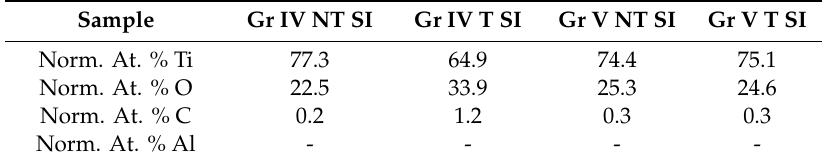
Table 7. Atomic percentages of the elements of the treated with TiO 2 film and non-treated SLA grade IV and V samples and treated with TiO 2 film and treated SLA grade IV and V samples. (GR IV: